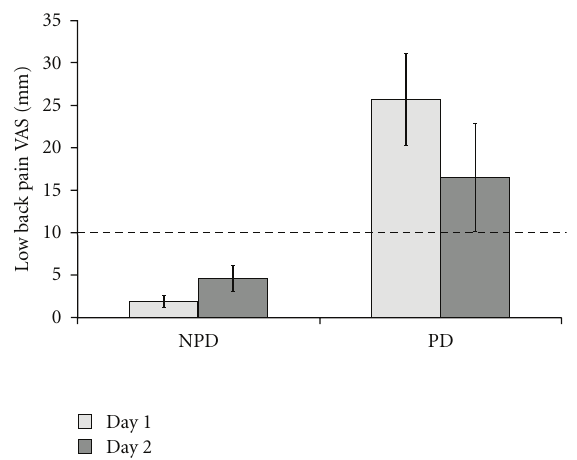
Figure 2: There were no between-day di ff erences for either group in VAS score for the low back during standing. The gray dashed line indicates the VAS cuto ff threshold for the PD group